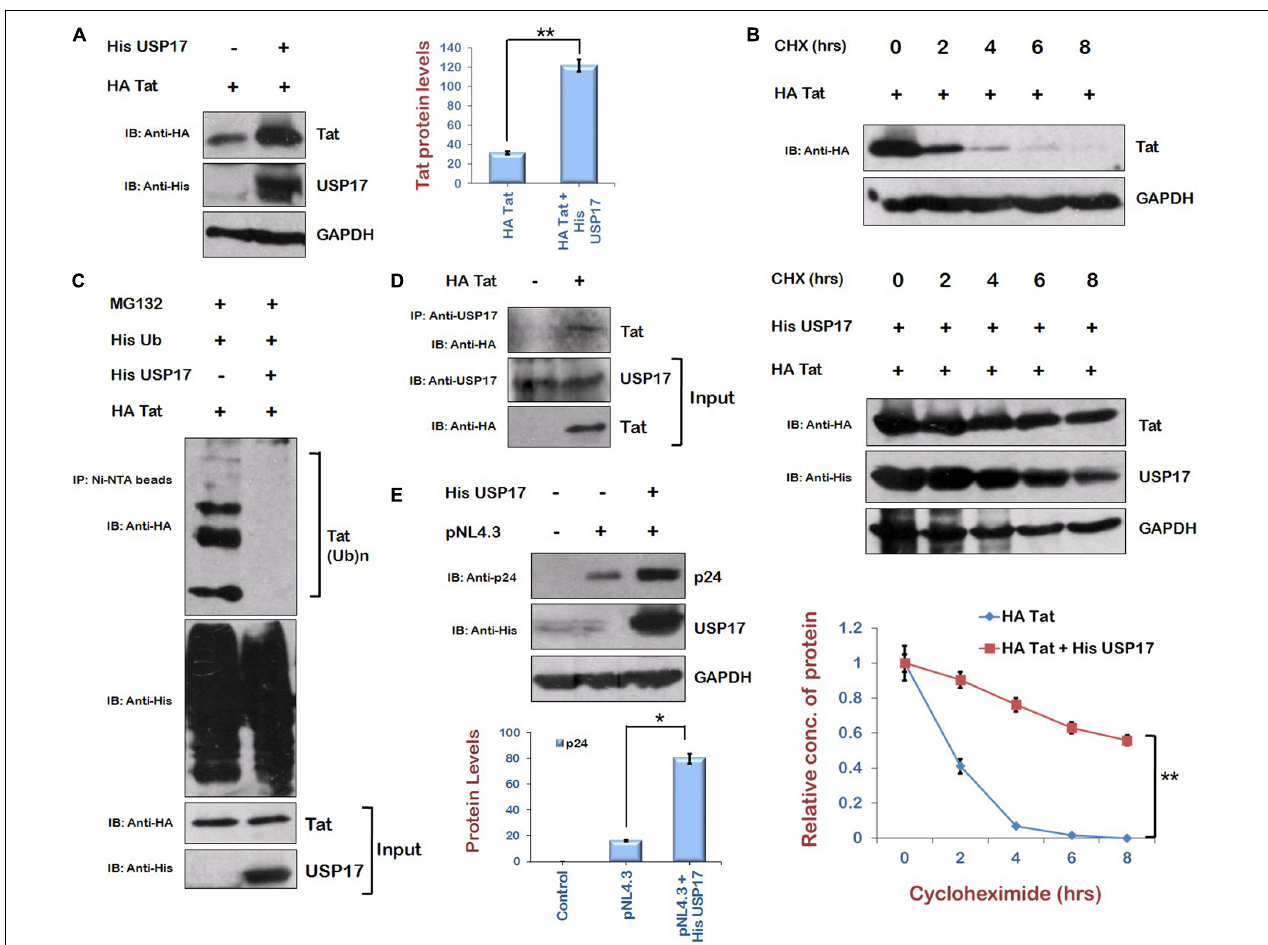
FIGURE 4 | Ubiquitin Specific Protease 17 stabilizes the expression of Tat by deubiquitination. (A) HEK-293T cells were cotransfected with HA Tat and His USP17 plasmids for 24 h. Cell lysates were analyzed by Western blotting using anti-HA, anti-His, and anti-GAPDH antibodies. (B) HEK-293T cells were transfected with HA Tat either alone or along with His USP17 for 24 h. Cells were treated with cycloheximide (100 µ g/mL) for the indicated time periods. Cell lysates were subjected to Western blot analysis using anti-HA, anti-His, and anti-GAPDH antibodies. Densitometric analysis was done by ImageJ and shown as line graph with error bars. (C) HEK-293T cells were cotransfected with His Ub, HA Tat, and His USP17 for 24 h. Cells were treated with MG132 (20 µ M) for 8 h. Cell lysates were subjected to immunoprecipitation with Ni-NTA beads followed by Western blotting with anti-HA antibody. (D) HEK-293T cells were transfected with HA Tat encoding plasmid. After 24 h of transfection, cell lysates were subjected to immunoprecipitation using anti–USP17 antibody–bound agarose beads followed by Western blotting using anti-HA antibody. (E) HEK-293T cells were cotransfected with HA Tat and pNL4.3 for 24 h. Cell lysates were subjected to Western blotting with anti-HA, anti-p24, and anti-GAPDH antibodies. Densitometry analysis was performed using ImageJ and shown as bar graph with error bars. Data obtained are presented as mean ± s.e.m. of three independent experiments. p -value was calculated by two-tailed t -test (* p < 0.05, ** p <